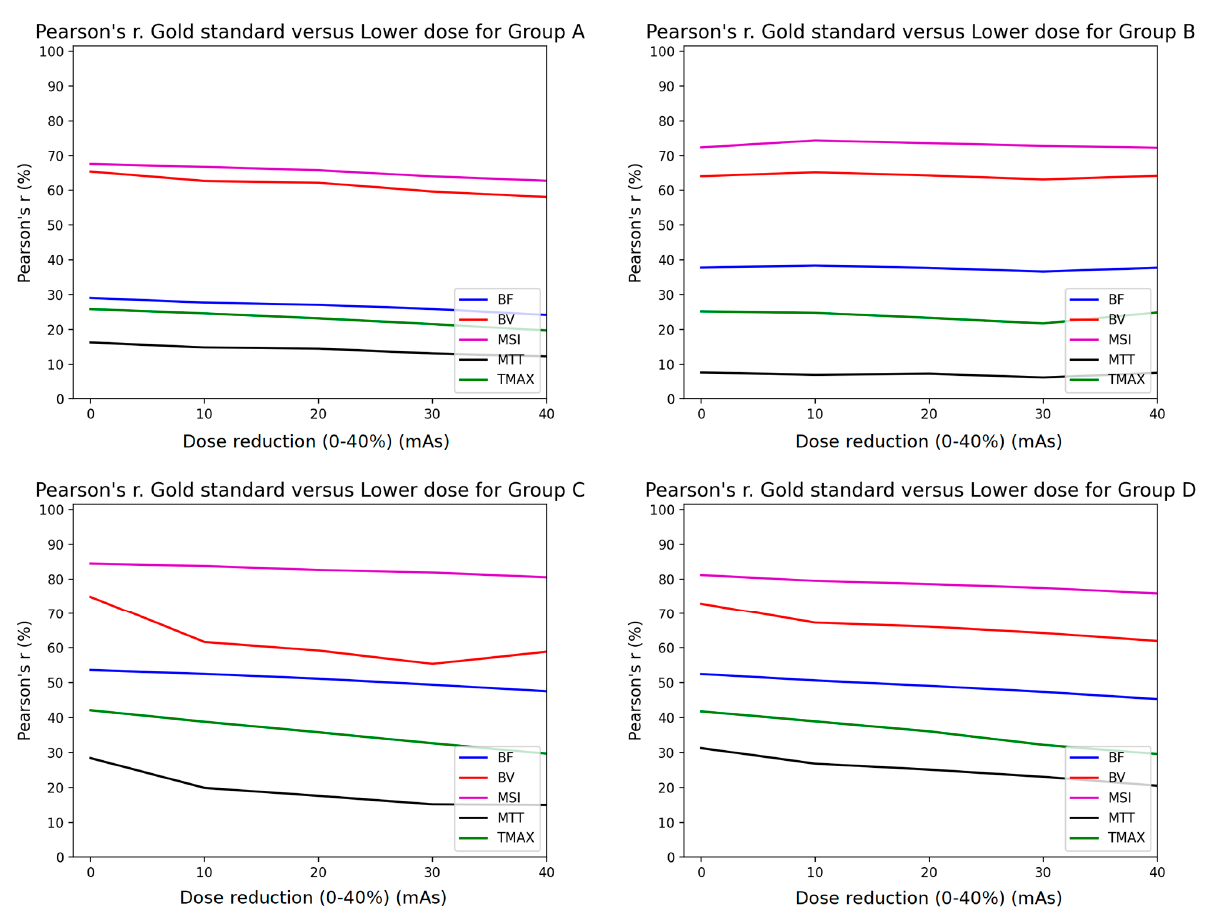
Figure 5. Comparison of Pearson’s correlation coefficient between GSmaps and the maps corresponding to lower mAs settings in combination to 1/3 temporal sampling for all study groups ( A – D ). Table 2. Mean values of parametric maps with respect to dose and temporal resolution reductions. 1/2 Temporal